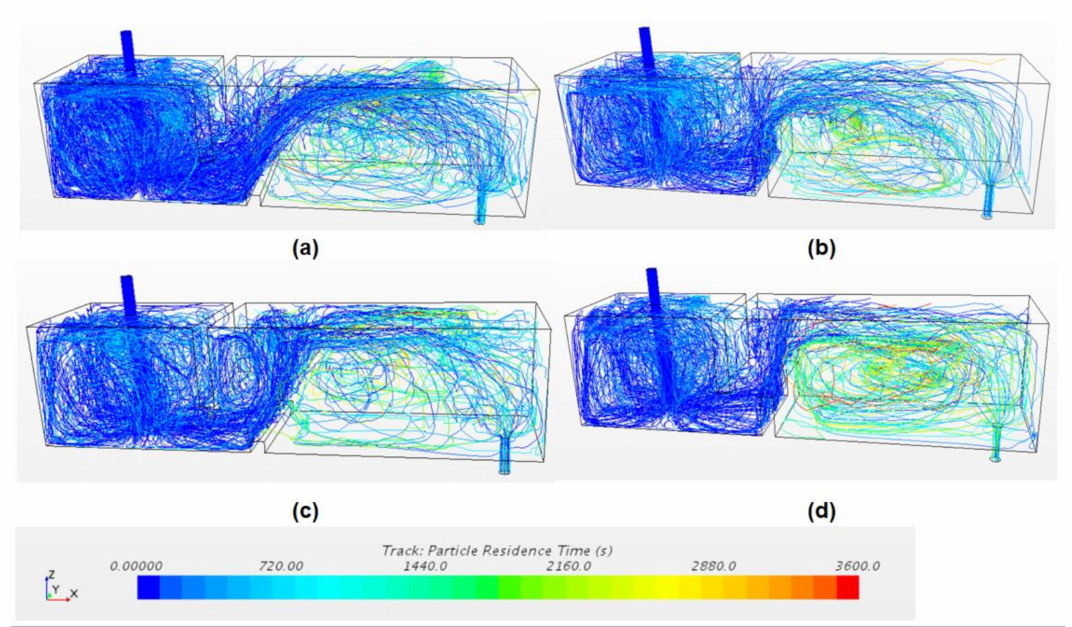
Figure 7. Trajectories of inclusion particles (inclusion density: 3500 kg m − 3 ; inclusion size: 10 µ m): ( a ) Case 1-W + LD, ( b ) Case 2-W + HD, ( c ) Case 3-W + LD + G, ( d ) Case 4-W + HD +